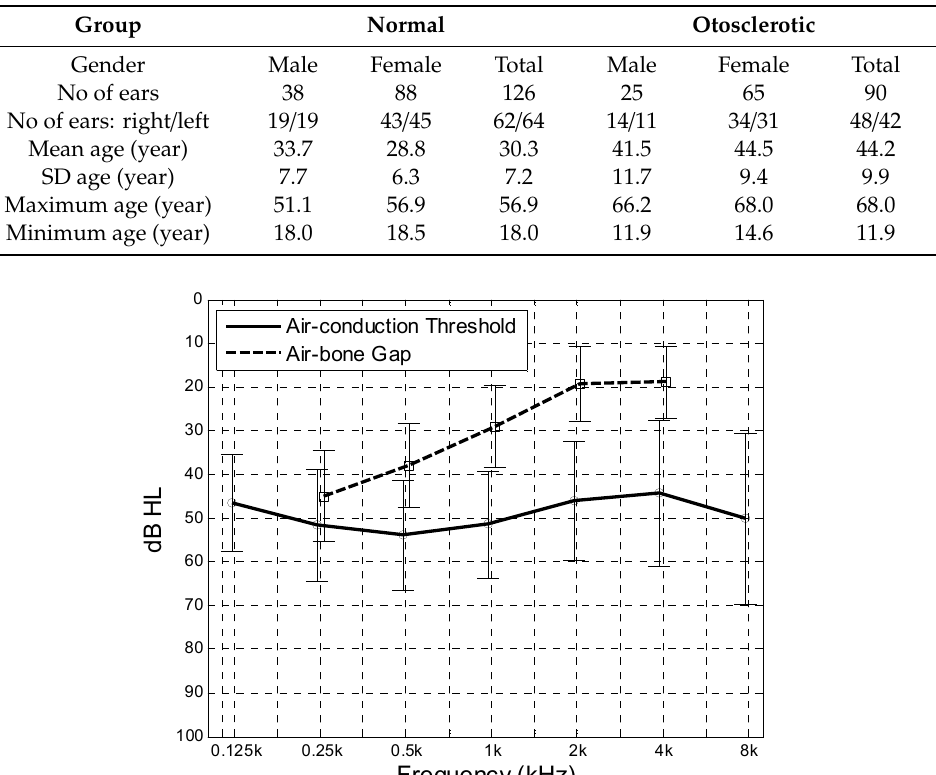
Table 1. Age, gender, and ear side of investigated groups.